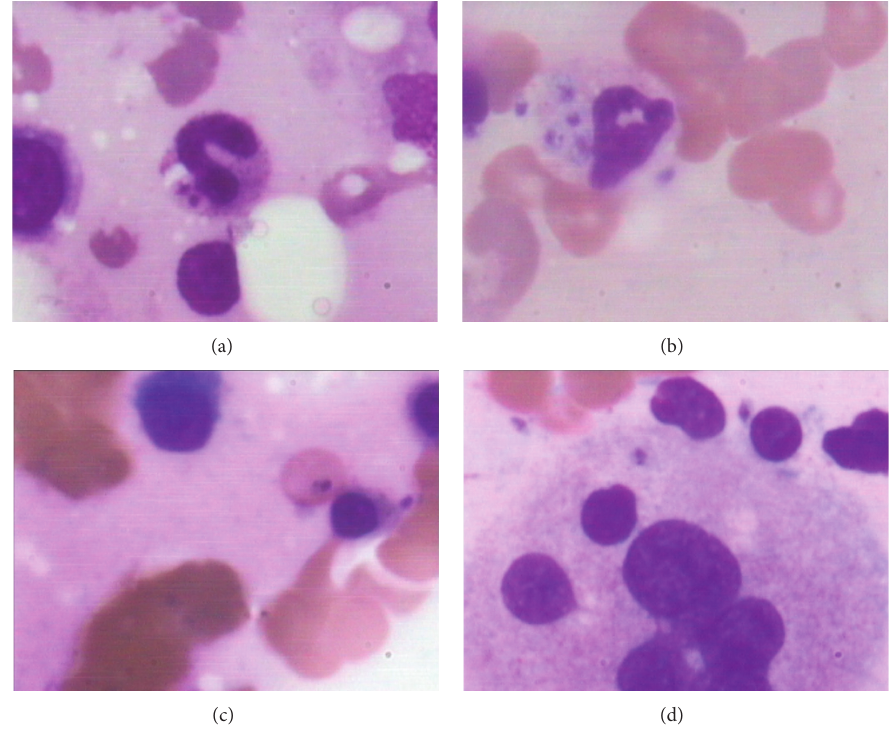
Figure 4: Bone marrow aspirate showing presence of LD bodies in nonhistiocytic cells, (a) LD body in metamyelocyte, (b) LD body in polymorph showing dysmyelopoiesis, (c) LD body in RBC and (d) LD body in megakaryocyte (Jenner Giemsa; × 1000).